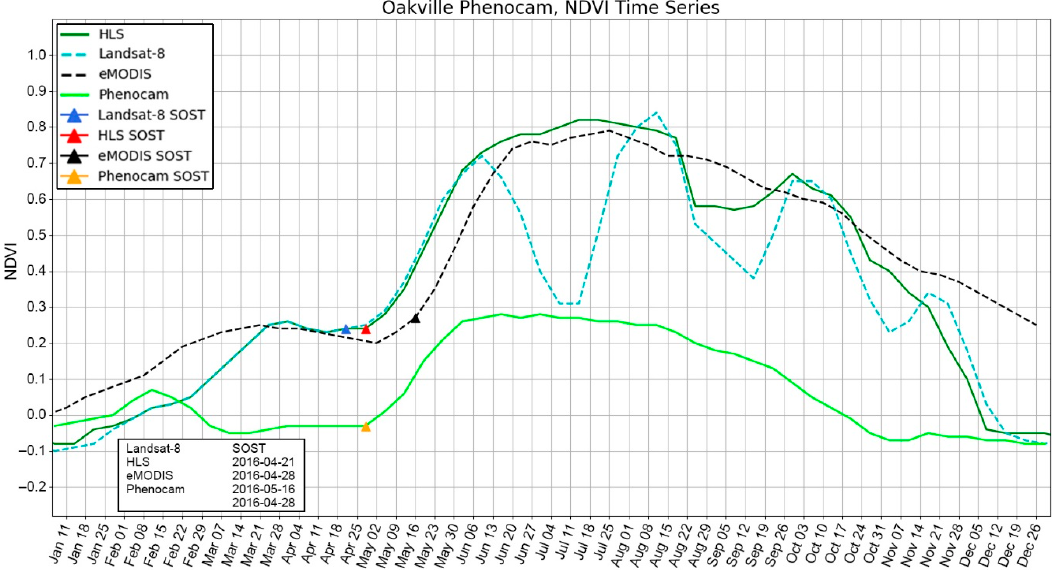
Figure 7. NDVI trajectories and calculated SOST from time series of Landsat-8, HLS, eMODIS, and PhenoCam data for the Oakville PhenoCam location.